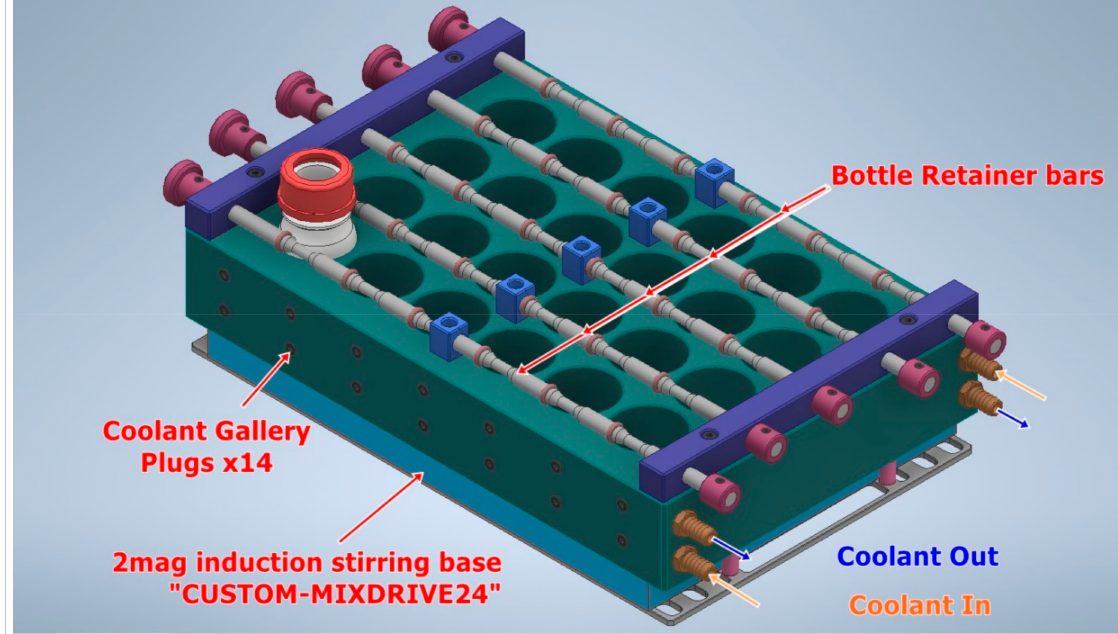
Figure 1. 24 × 100 mL temperature control and retention block (1 of 4) used to house 24 fermentation